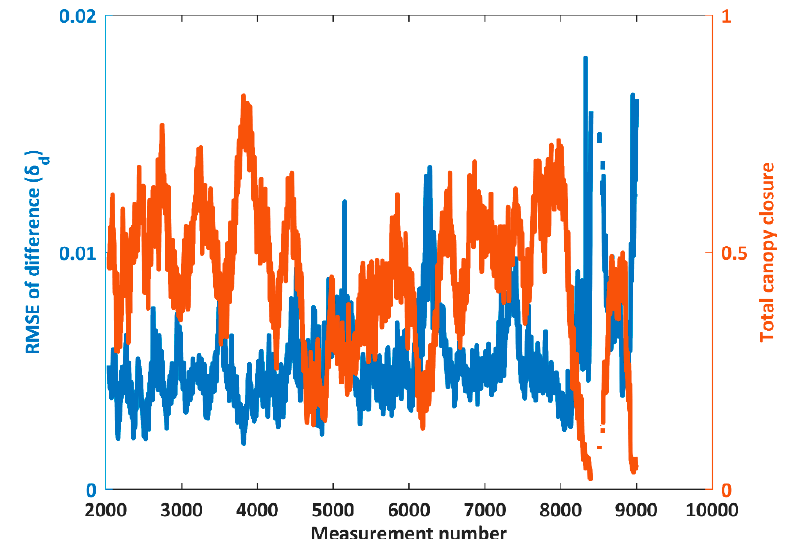
Figure 11. The RMSEs of the difference of CHP derived from Tomoradar waveforms and the LiDAR data (blue color) and the total canopy closure (red color) for all reserved measurements.